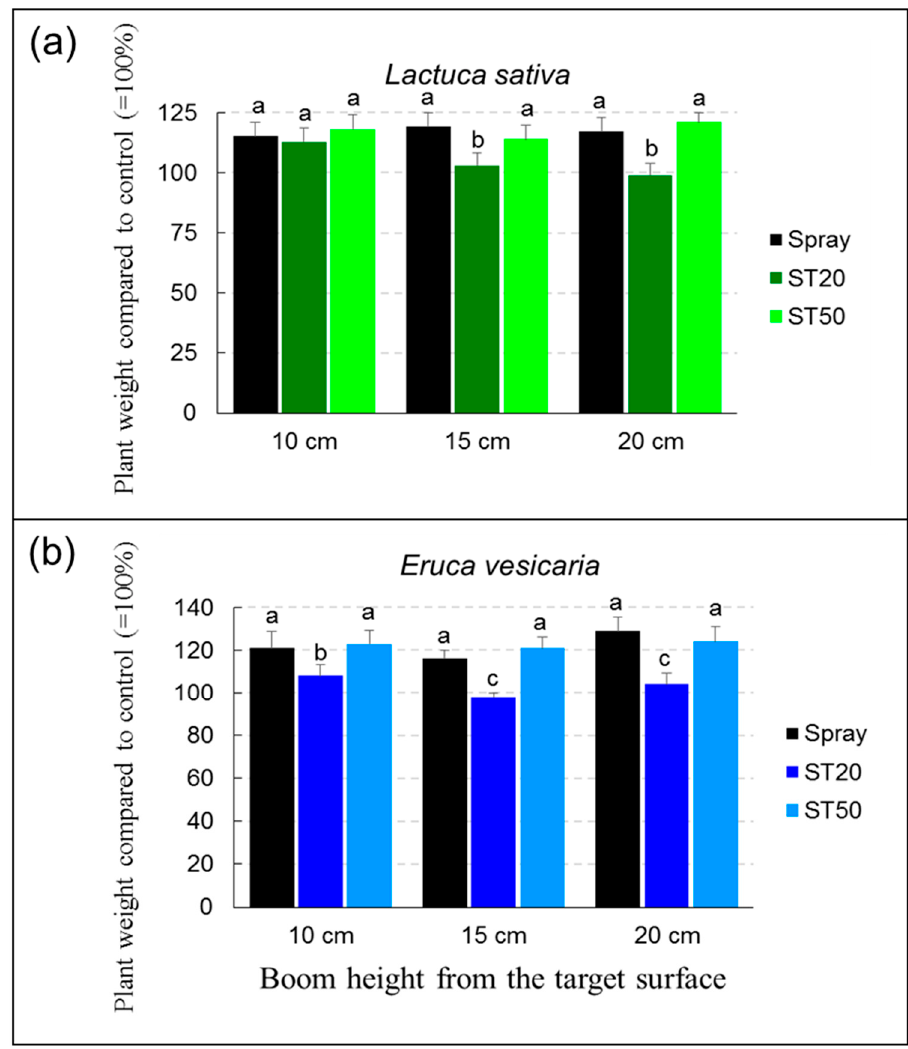
Figure 14. Growth of Lactuca sativa ( a ) and Eruca vesicaria ( b ) treated with Trichoderma harzianum at three application heights (10, 15, and 20 cm) with spray system, ST20, and ST50 integrated in the DEMO. Data are means ± standard deviation; different letters indicate statistically significant differences (Duncan’s test).